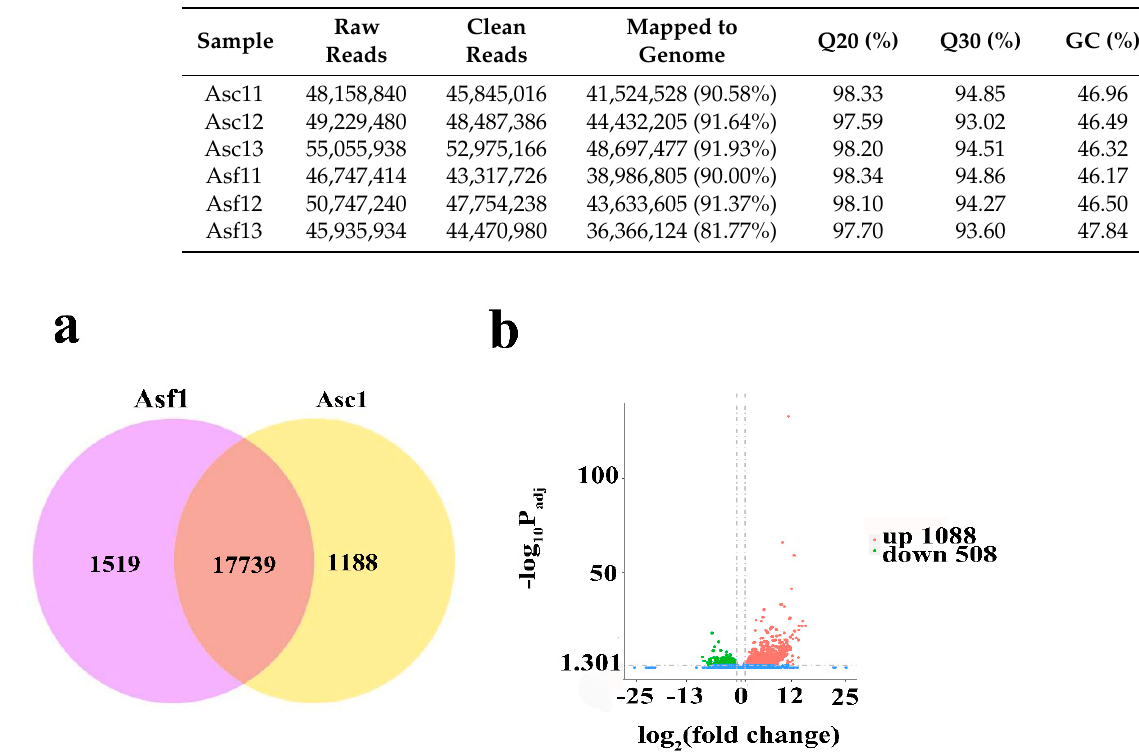
Figure 1. Global analysis of gene expression in specific xylem tissues of wound-induced agarwood formation. ( a ) The Venn diagram shows common and unique expressed genes in Asf1 and Asc1; ( b ) the number of up-regulated and down-regulated DEGs from Asf1 vs. Asc1. We judged the significance of gene expression difference with P adj ≤ 0.05 and |log 2 (fold change)| ≥ 1.